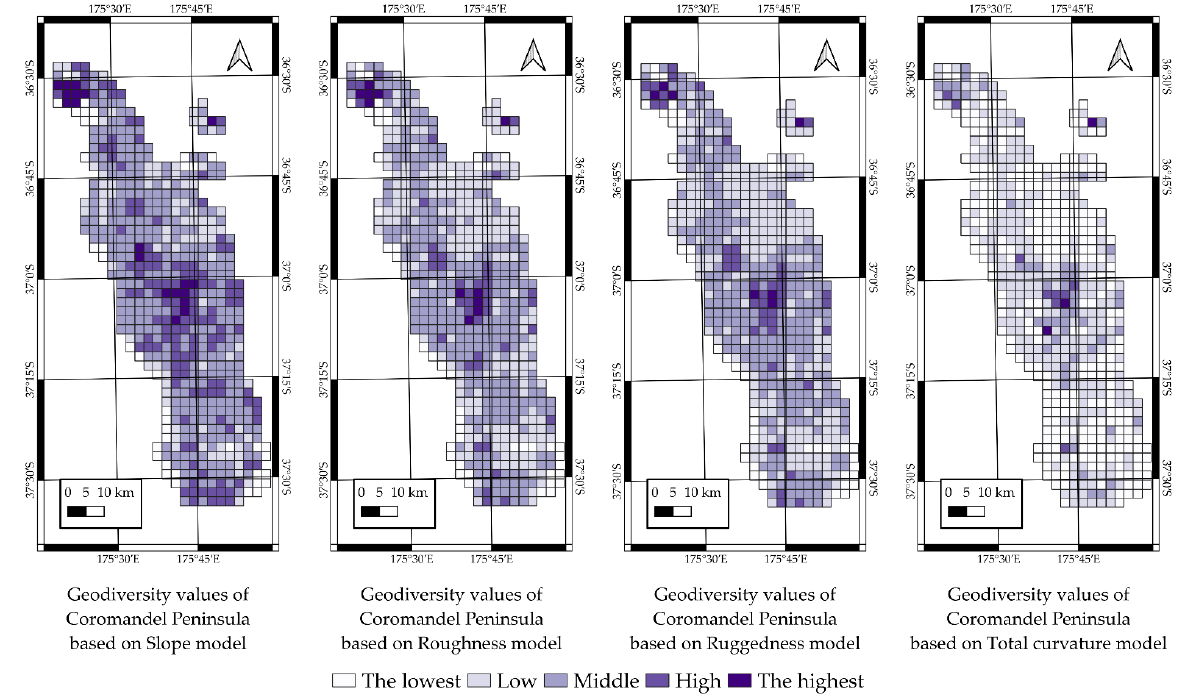
Figure 3. Geodiversity values of Coromandel Peninsula for geosite recognition, based on numerical geomorphological models: slope, roughness, ruggedness, and total curvature. Equal interval mode of evaluation.